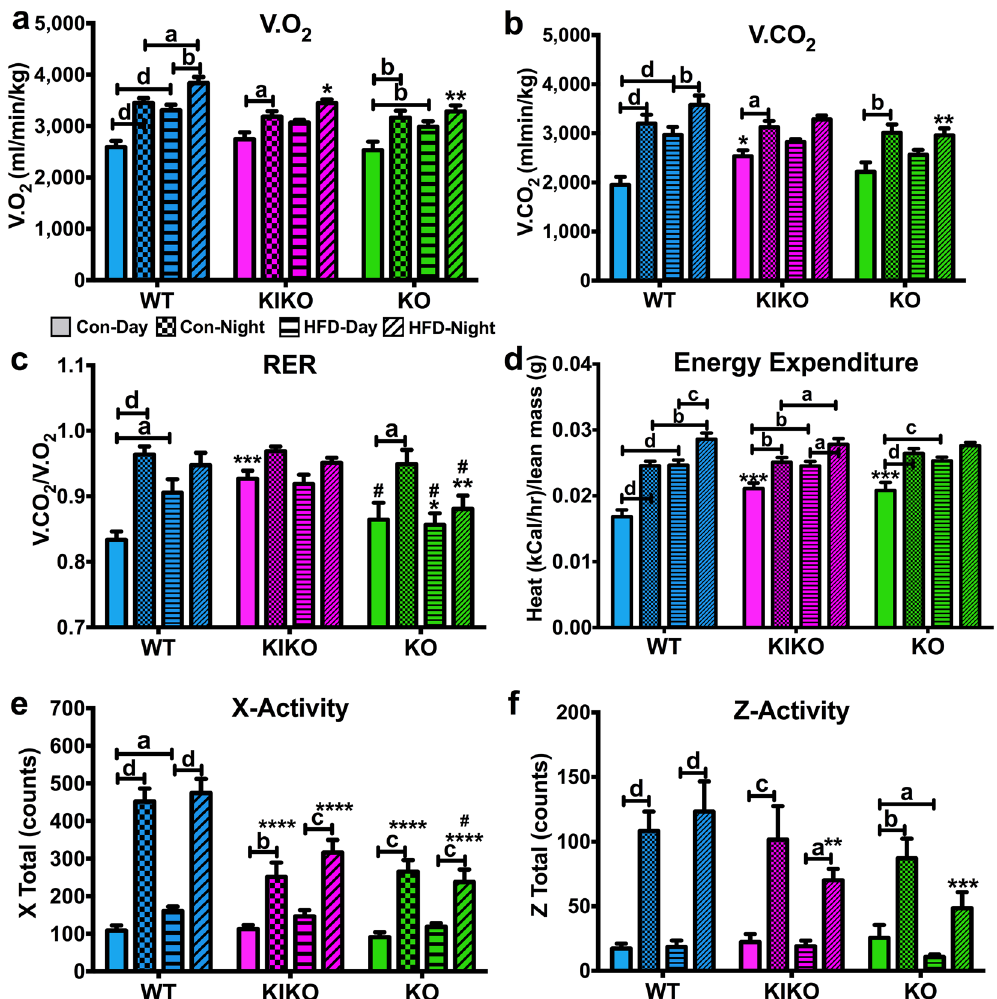
Figure 2. Metabolic and activity parameters in females from all genotypes after 20 weeks of adult chow diet determined using the CLAMS. ( a ) V.O 2 (ml/min/kg); ( b ) V.CO 2 (ml/min/kg); ( c ) Respiratory exchange ratio (RER) (V.CO 2 /V.O 2 ); ( d ) Energy expenditure (kCal/hr/lean mass (g)); ( e ) X-plane activity (counts); and ( f ) Z-plane activity (counts). Data were analyzed by a multi-factorial ANOVA (genotype, maternal diet, time)